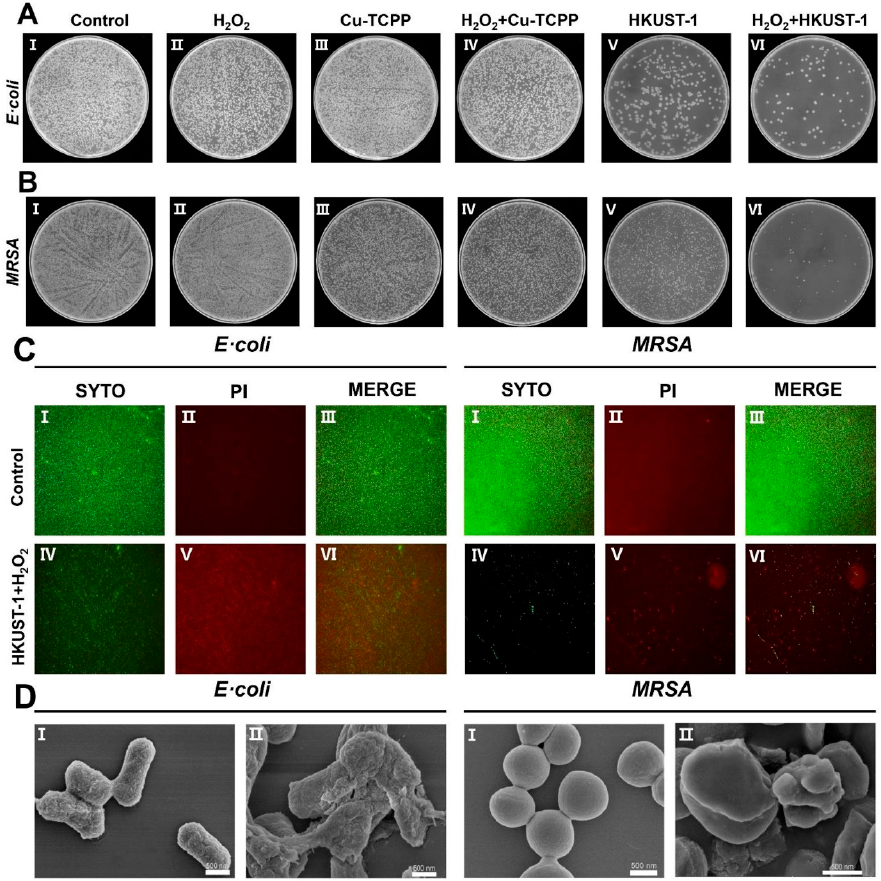
Figure 3. Photographs of the colonies against E. coli ( A ) and MRSA ( B ) with different treatments, (I) PBS (II) H 2 O 2 (III) Cu-TCPP (IV) Cu-TCPP + H 2 O 2 (V) HKUST-1 (VI) HKUST-1 + H 2 O 2 . ( C ) Fluorescence images of E. coli and MRSA that had undergone various treatments (I), (II) and (III) PBS and (IV), (V) and ( Ⅵ ) HKUST-1 + H 2 O 2 . ( D ) SEM images of E. coli and MRSA by various treatments: (I) PBS, (II) HKUST-1 + H 2 O 2 . Scale bar = 500 nm.